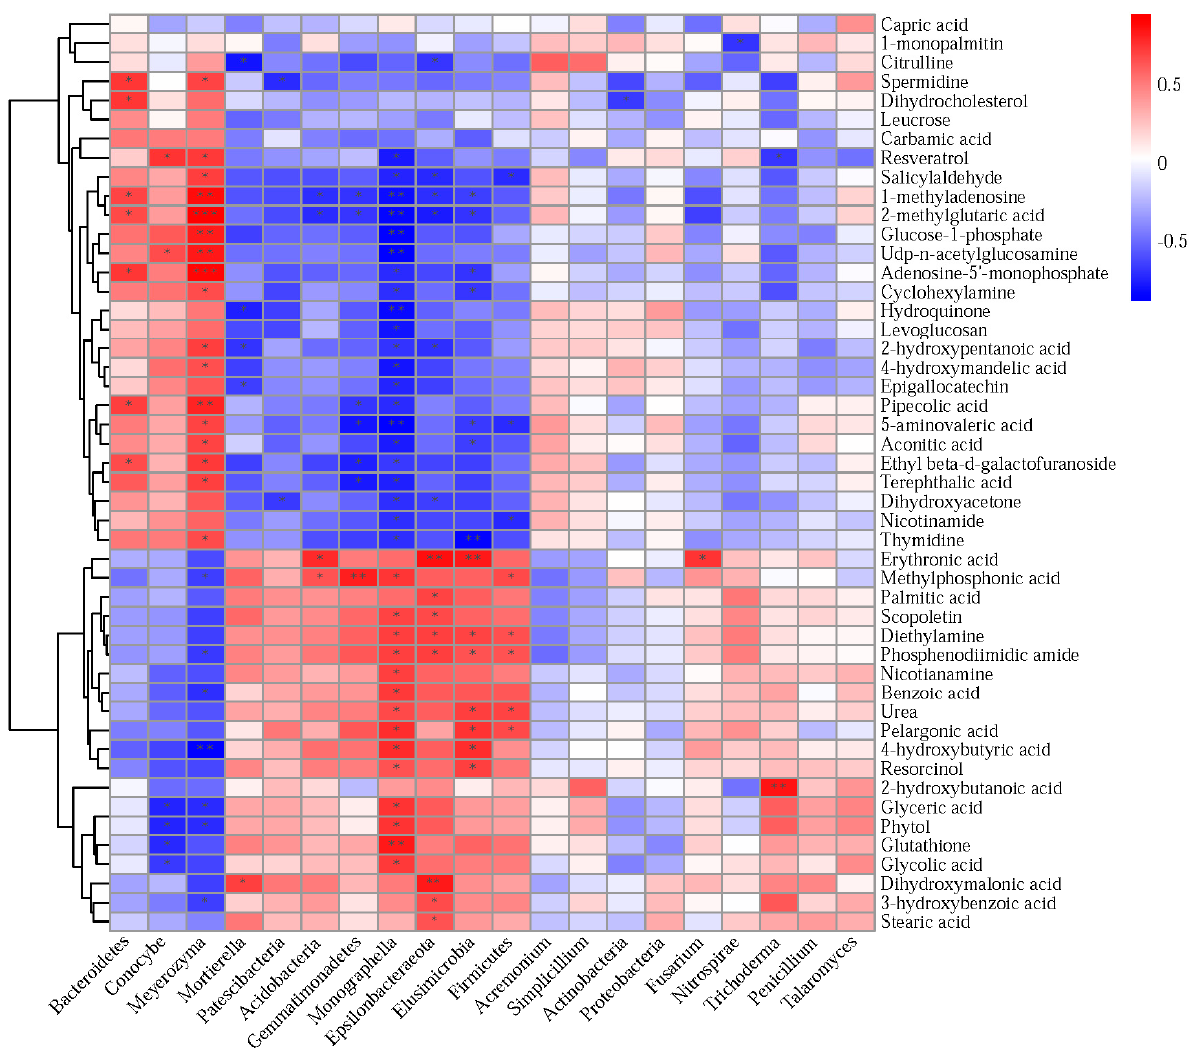
Figure 6. Heat map of the correlation analysis between soil microbial communities and differential metabolites. Red represents a positive correlation and blue represents a negative correlation; the darker the color, the greater the correlation. ***, **, and * represent significance at p < 0.001, p < 0.01, and p < 0.05.